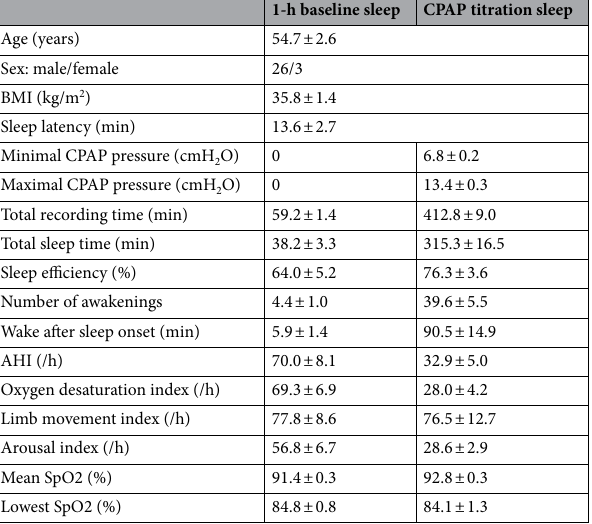
Table 1. The demographics of patients and results of polysomnography. Continuous positive airway pressure (CPAP). Body mass index (BMI). Apnea–hypopnea index (AHI). Data are expressed as the mean ± standard